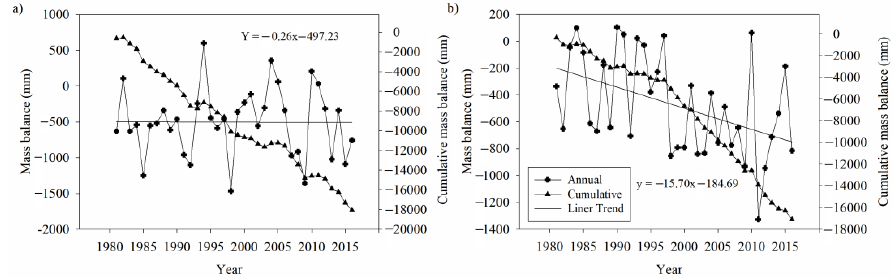
Figure 9. Mean annual and cumulative glacier mass balance for Tuyuksuyskiy glacier and Urumqi glacier No. 1 in the TS from 1980 to 2015. ( a ) Ts. Tuyuksuyskiy glacier; ( b ) Urumqi glacier No. 1. Glacier meltwater is an important water supply for glacier lakes and mountain water balance. In recent years, the accelerated shrinkage of glaciers and their resulting mass loss have been the main water resources for the expansion of the glacial lakes [54,55]. Since 2002, the total water storage in the TS has continuously declined at a rate of −9.98 mm/a (Figure 10). Regions characterized by higher losses in glacier area also experienced signif- icant water storage loss. For example, the glacier area in the Central TS exhibited the larg- est decrease during the 1990 – 2015 period, shrinking by about 805.08 km 2 . This equates to about 46.27% of the TS glacier area. Water storage losses in the Western TS measured −14.89 mm/a. In the Northern TS, glacier area decreased by 456.43 km 2 , and the water storage loss measured −11.75 mm/a. It is worth noting that minor glacier shrinkage is often accompanied by minor storage loss, as occurred in the Western TS where glacier area and water storage decreased by only 374.16 km 2 and −5.94 mm/a, respectively. In the Eastern